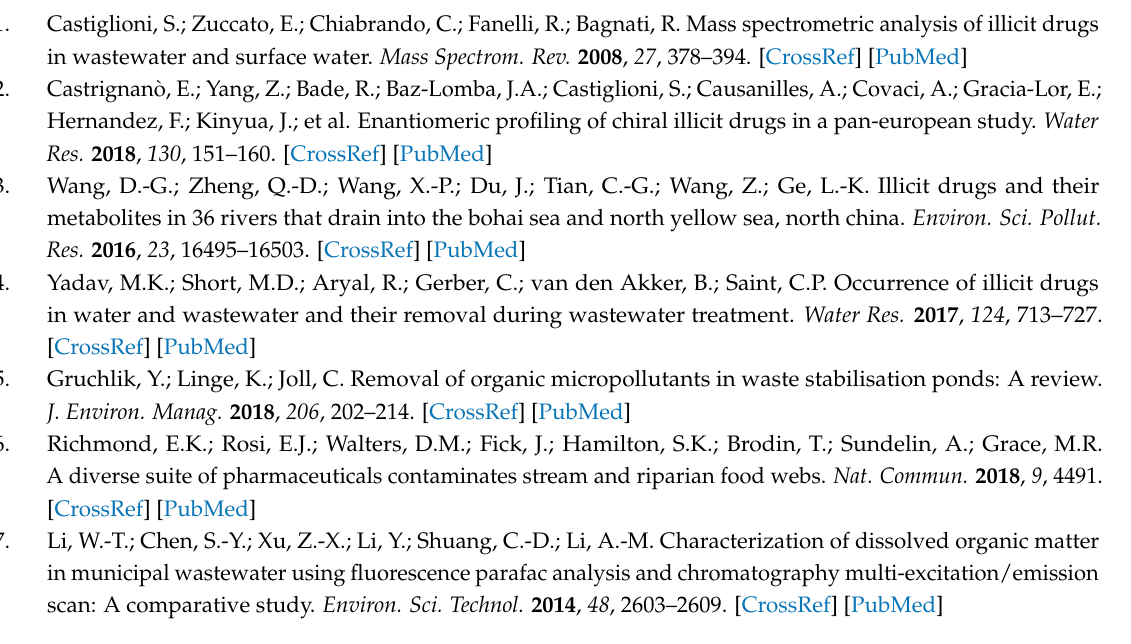
Table S1: Characteristics of wastewater treatment plants selected for the study, Table S2: Average dissolved organic carbon concentration in influent and effluent samples during the study period ± standard deviation, Figure S1: Visual example of fluorescence EEM’s of the influent and effluent of WWTP1 and WWPT4. Author Contributions: Conceptualization, M.K.Y., R.A. and C.P.S.; formal analysis, M.K.Y.; funding